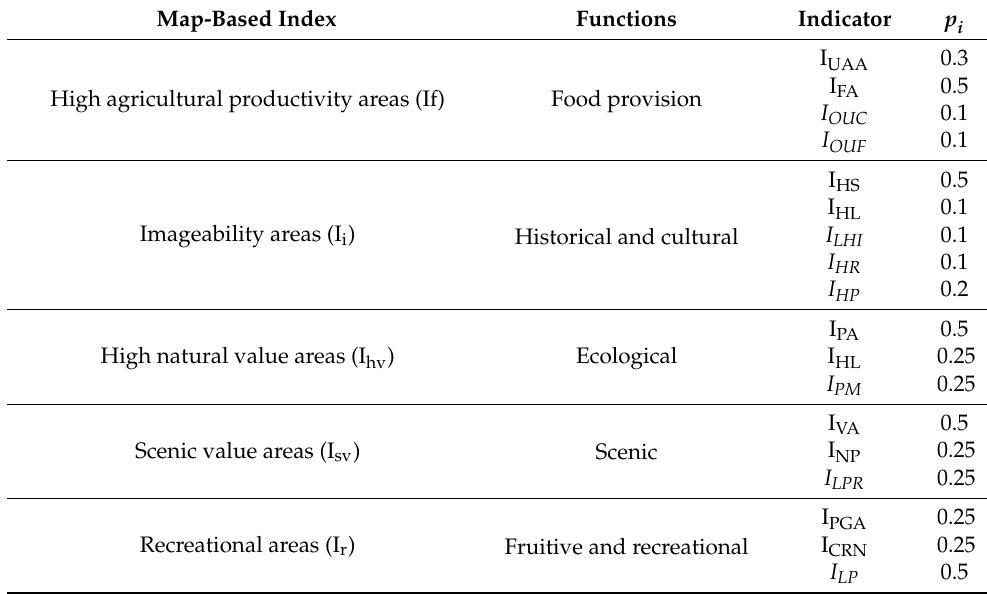
Table 2. Criteria for the functional classification of peri-urban open